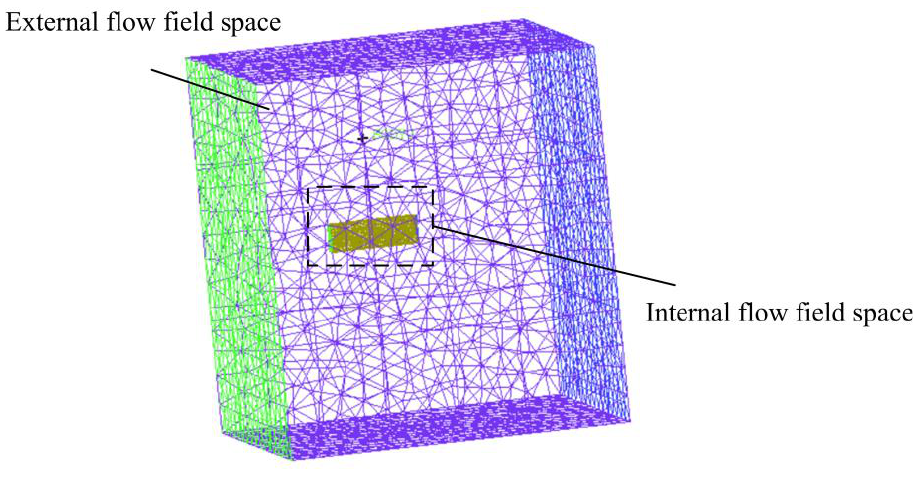
Figure 6. Construction of the external flow field area.